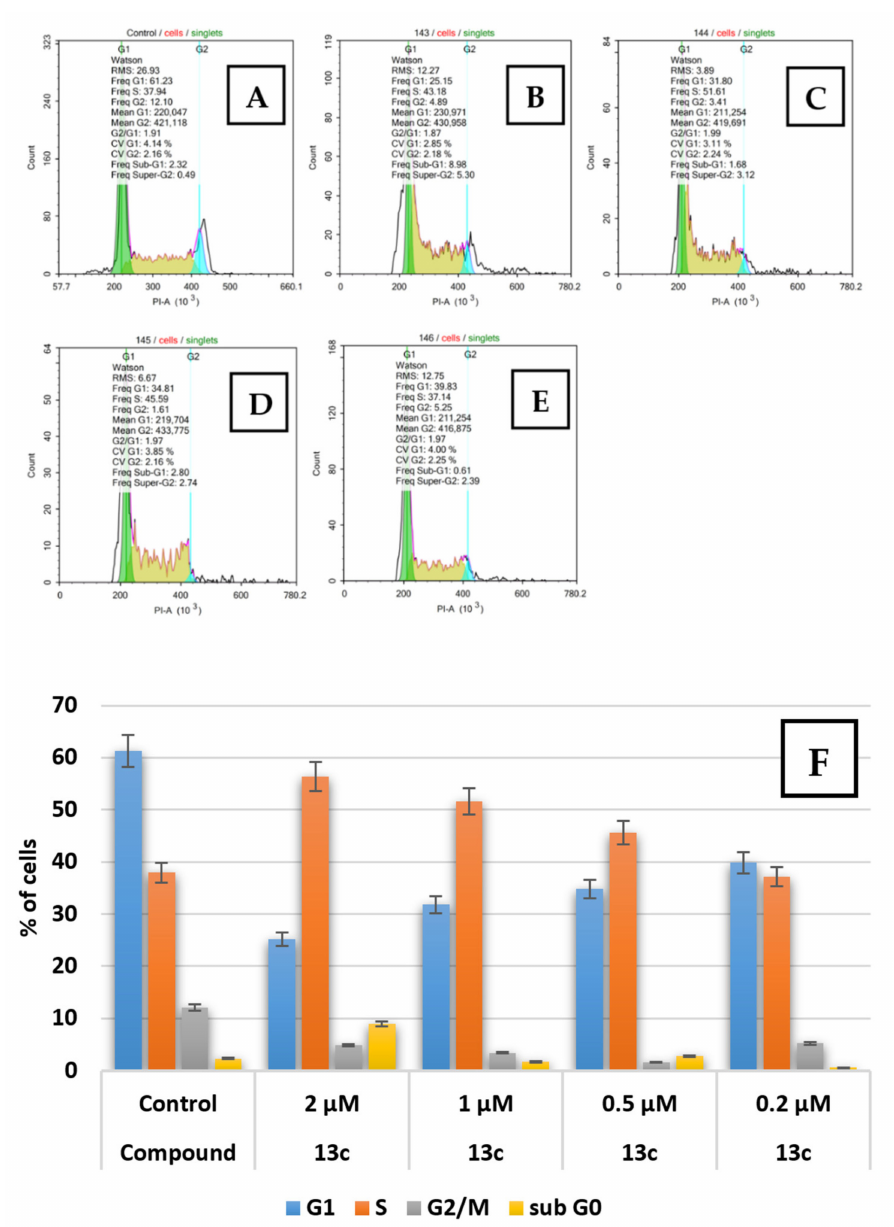
Figure 4. Cytofluorometric analysis of cell cycle phases ( A – E ) in Jurkat tumor cells treated with com- pound 13c . The cells treated with various concentrations of 13c and stained with PI. The incubation time of compound 13c with the cells was 24 h. ( A ) Control sample untreated with the test compound; ( B ) Compound 13c in 0.2 µ M concentration; ( C ) Compound 13c in 0.1 µ M concentration; ( D ) Com- pound 13c in 0.05 µ M concentration; ( E ) Compound 13c in 0.025 µ M concentration; ( F ) Histogram of cell cycle phases in Jurkat cells treated with compound 13c . Results are expressed as mean ± SE ( n =